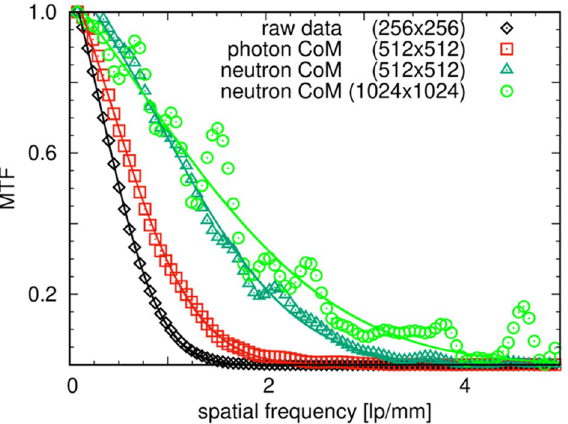
Figure 4. MTF for radiographs of different event-types and sub-pixel pitch for 15 × 15 cm 2 FoV neutron imaging: for raw event data at the native resolution of the chip; event-based data at sub-pixel resolution by CoM of the photon events at ½ pixel-pitch; CoM of neutron events using ½ pixel-pitch; and CoM of neutron events using ¼ pixel-pitch. Solid lines in the corresponding colors are fitted error functions to the